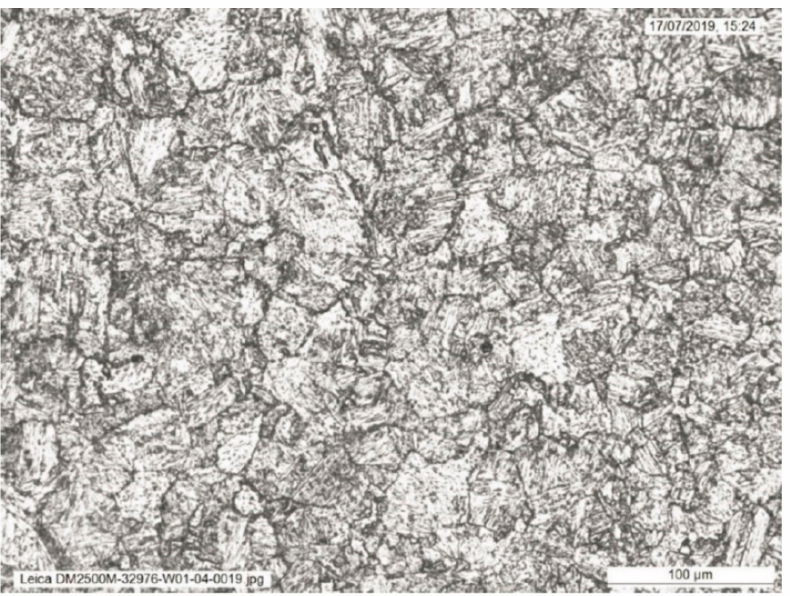
Figure 5. Microstructure in the location of the ICGCHAZ from Figure 3 at highest magnification, showing coarse grains decorated with second phase precipitates around the grain